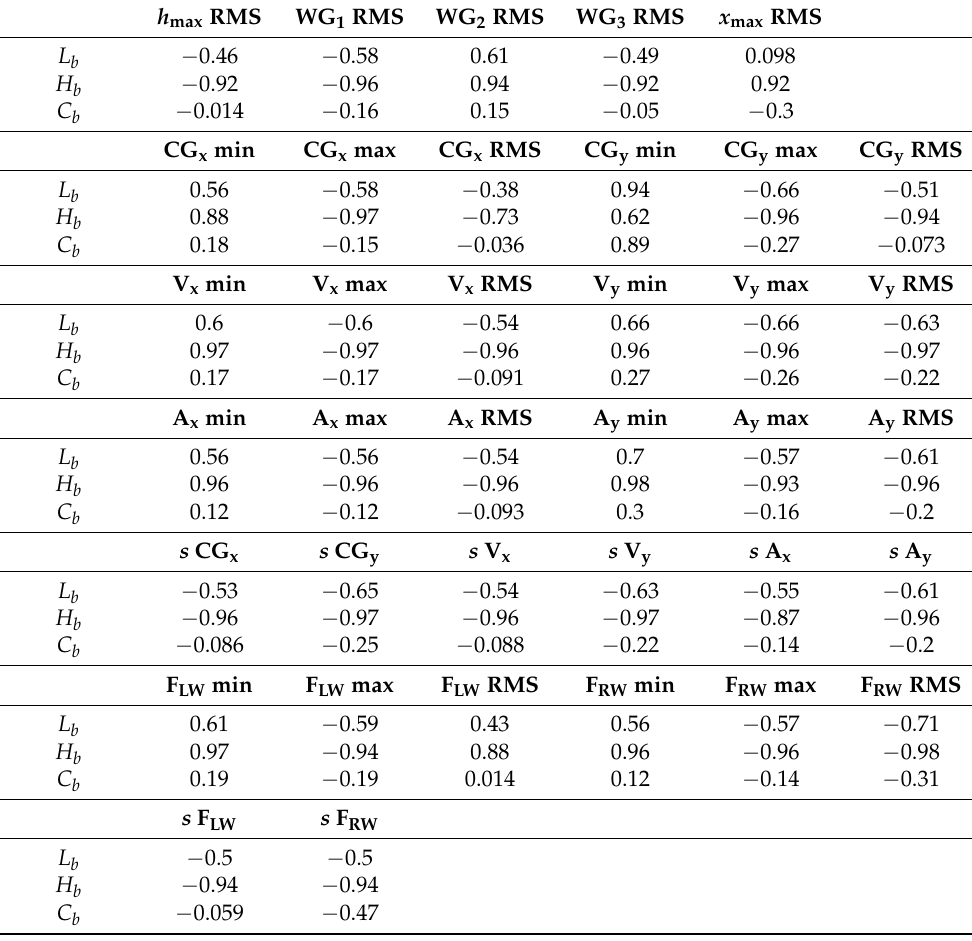
Table 1. Pearson’s linear correlation